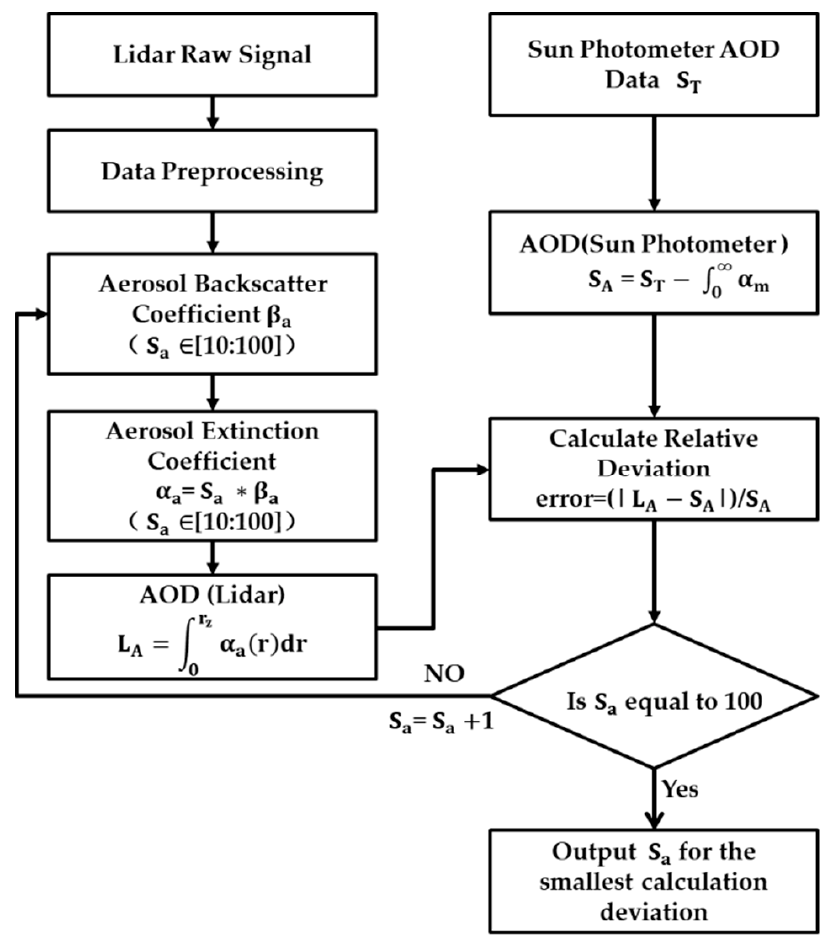
Figure 2. Flow chart of calculating aerosol lidar ratio. The error between the AOD measurement obtained from the multi-channel sun pho- tometer at a wavelength of 500 nm and the AOD value measured by the lidar at 532 nm is negligible. The calculated results are shown in Figure